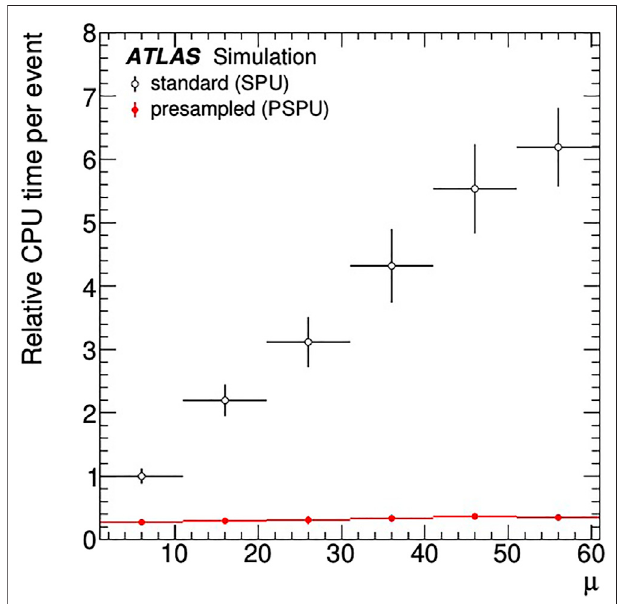
FIGURE 1 | Comparison of the average CPU time per event in the standard ATLAS pileup digitization (black open circles) and the pre-sampled pileup digitization (red fi lled circles) as a function of the number of pp collisions per bunch crossing ( μ ). The CPU time is normalized to the time taken for the standard pileup for the lowest μ bin. Taken from Ref.